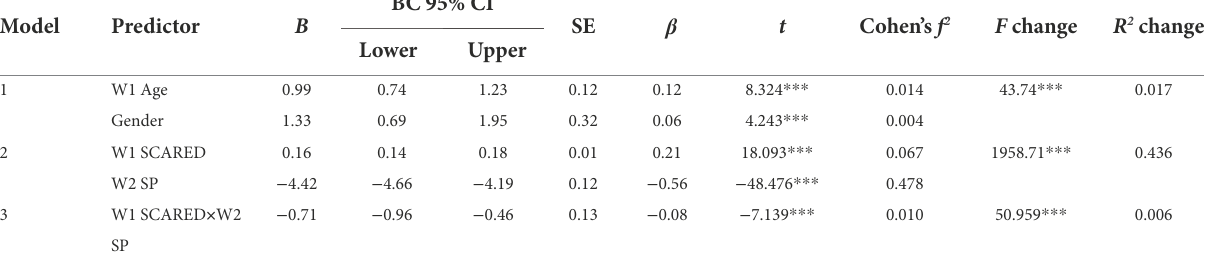
TABLE 7 Hierarchical multiple regression analyses for the predicting effects of anxiety (SCARED) at Wave 1 and life meaning (SP) at Wave 2 on depression (CES-D) at Wave 2.